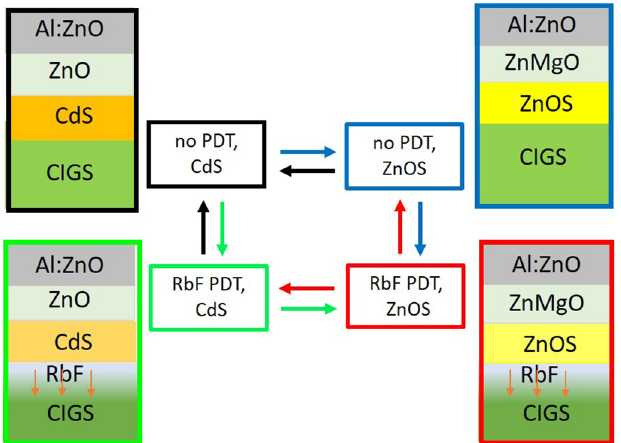
Fig. 1. The architectures and relationships between the four types of cells analyzed in